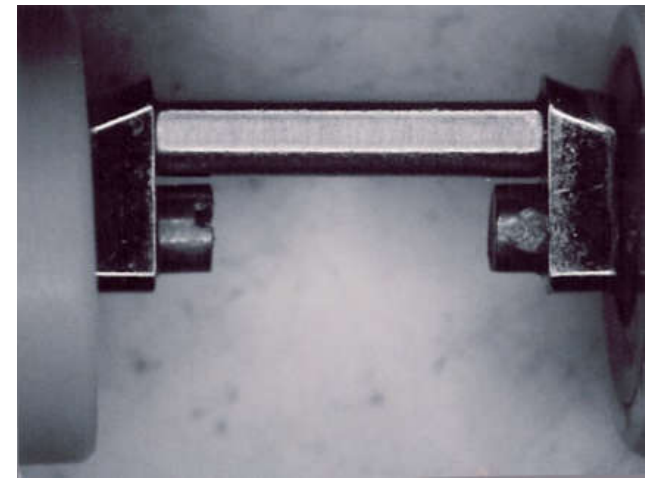
Figure 5. Sample fixed in the stress corrosion holders.